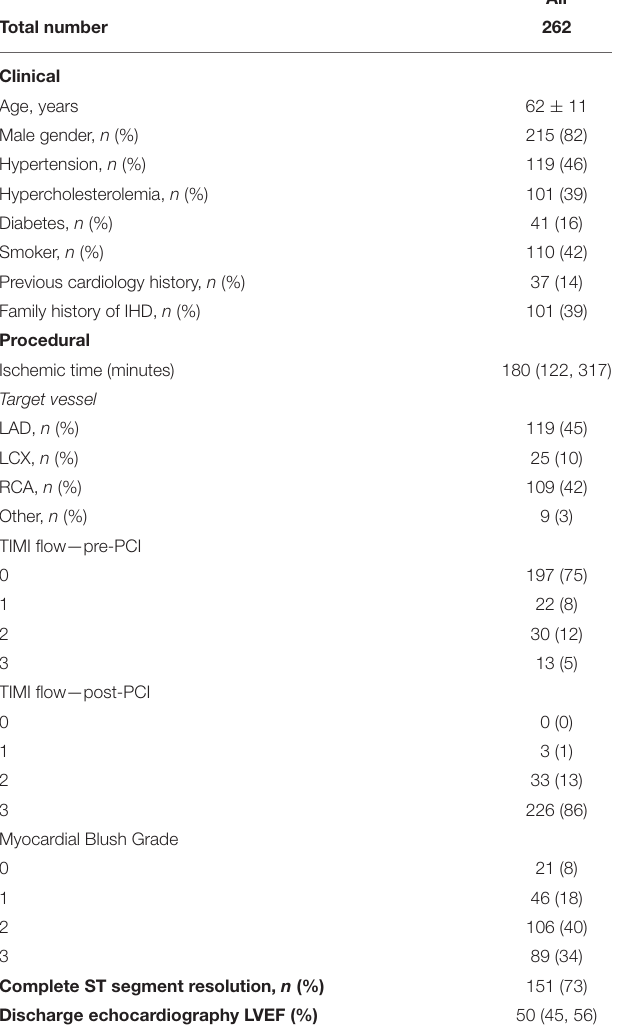
TABLE 1 | Clinical, procedural and echocardiographic characteristics.